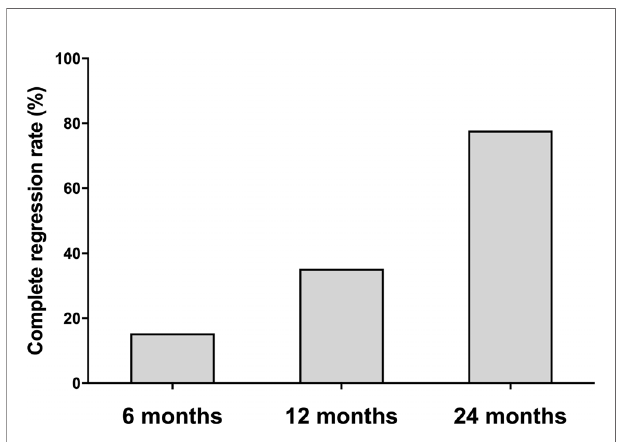
FIGURE 2 | The complete regression rate at each follow-up point. The complete regression rate increased during 24-month follow-up. The number of absorbed ablation zone was 8/52, 12/34 and 7/9 patients at 6, 12, and 24 months